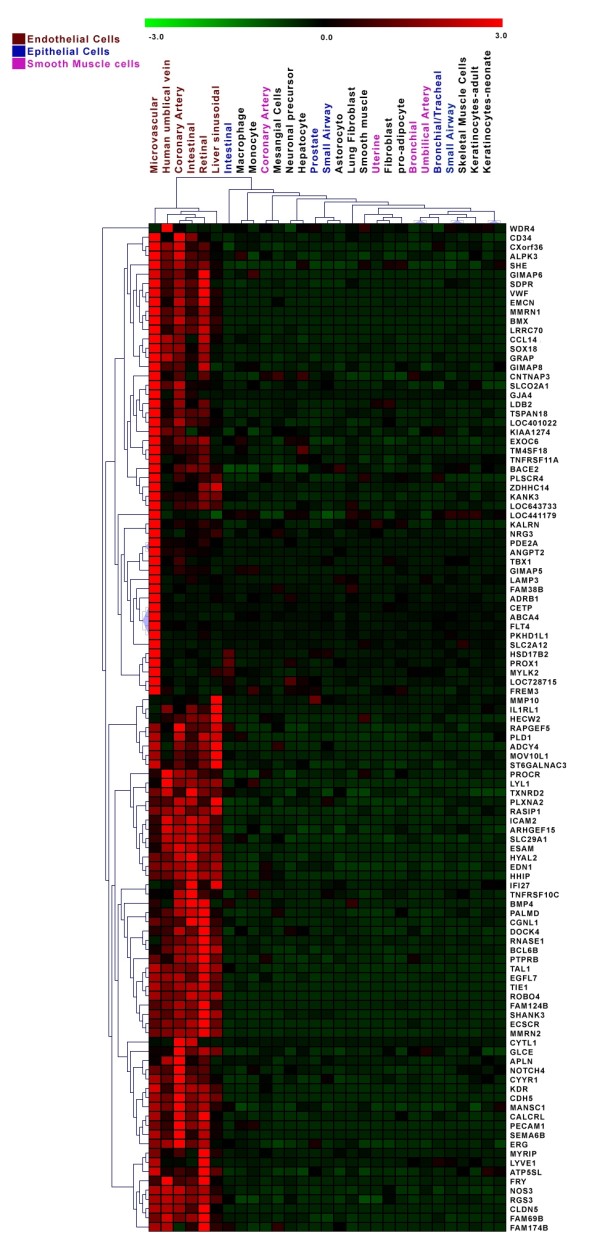
Expression of ECs restricted genes in REFEXA database. A) Hierarchical clustering analysis of EC-restricted expression genes using REFEXA gene expression data. The columns represent the samples (primary endothelial and non endothelial cells from REFEXA database) and rows represent the genes. The detailed information about the primary cells can be obtained from REFEXA database http://157.82.78.238/refexa/main_search.jsp. Gene expression is shown with pseudocolor scale (-3 to 3) with red denoting high expression level and green denoting low expression level of gene.